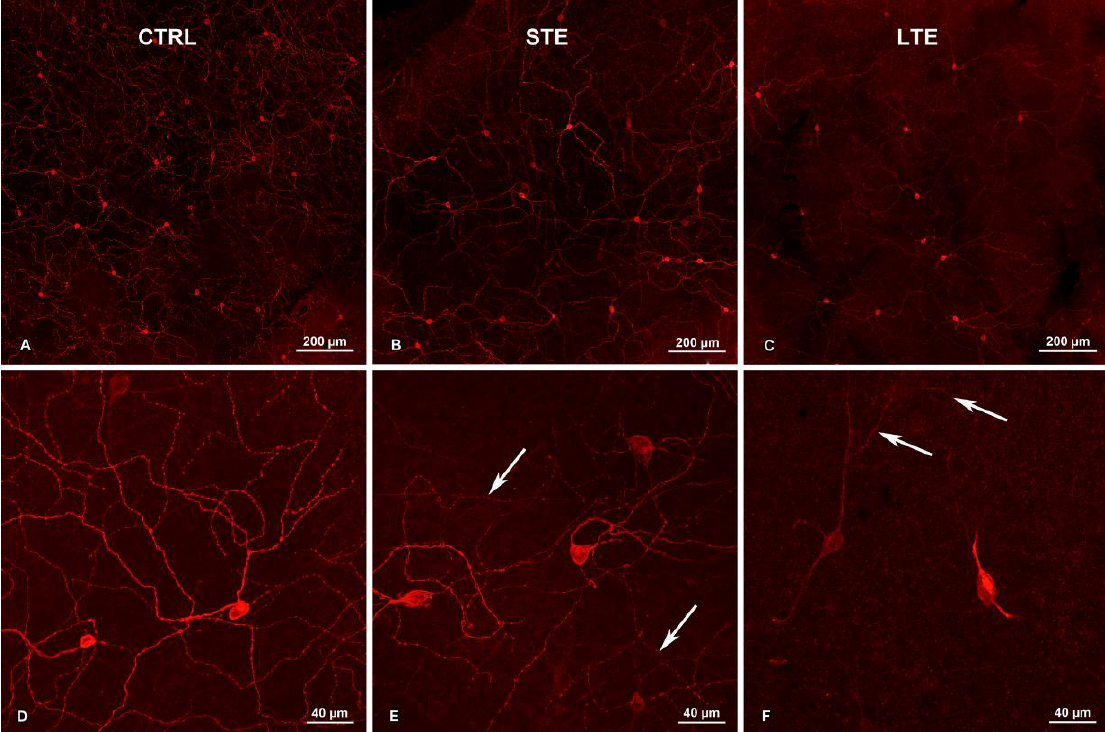
Figure 2. Effect of blue light exposure on melanopsin distribution in intrinsically photosensitive retinal ganglion cells (ipRGCs) in whole-mount retinas from Wistar rats. The rats were exposed to 12 h white light (150 lx) and 12 h darkness for 10 d (control, CTRL; 9 rats), cycles of 12 h blue light (150 lx) and 12 h darkness for 10 d (long-term exposure, LTE; 9 rats), and constant blue light (150 lx) for 2 d (short-term exposure, STE; 9 rats). ( A ) CTRL (20 × ). Note: dense network of melanopsin-positive dendrites. ( B ) CTRL (40 × ). Multiple melanopsin-positive dendrites with varicosities are visible. ( C ) STE (20 × ). A widespread dendritic network of melanopsin-positive processes is visible. ( D ) STE (40 × ). Multiple melanopsin-positive varicosities are also visible here. Note: immunoreactivity to melanopsin is decreased in outer stratifying dendrites (arrows). Varicosities are also less prominent here. ( E ) LTE (20 × ). Note: levels of melanopsin expression differ widely in the ipRGC somas. Relative to the other groups, melanopsin immunoreactivity is decreased in the dendrites, and the melanopsin-positive varicosities on the dendrites are less prominent. ( F ) LTE (40 × ). Melanopsin is present mostly in ipRGC somas and proximal dendrites. Note: lack of varicosities on these processes and decreased melanopsin immunoreactivity in outer stratifying dendrites (arrows). Samples were visualized and photographed with a confocal microscope (LSM900,